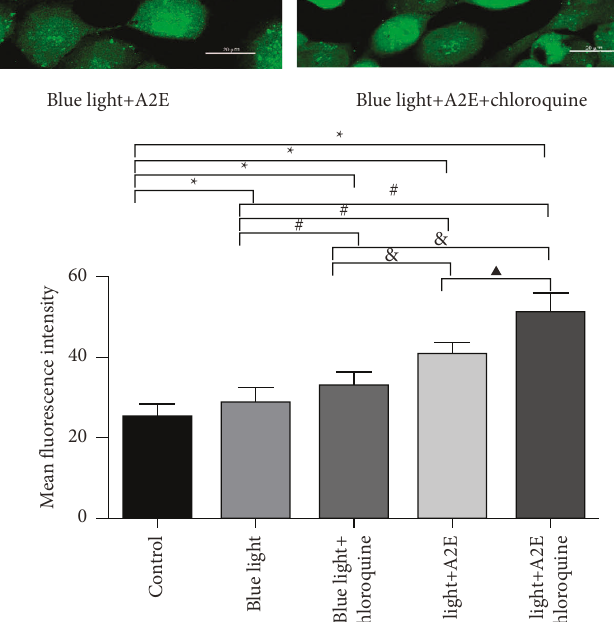
Figure 2: The cytoplasmic Ca 2+ level. To determine the Ca 2+ level in the cytoplasm, the fluorescence intensity of Ca 2+ in RPE cells was assessed by confocal microscopy using the Ca 2+ -sensitive dye Fluo-3/AM. Scale bar � 20 µ m. The graph shows the quantified data. The data are presented as the mean ± SD ( n � 3). An LSD test was conducted following one-way ANOVA. ∗ P < 0 . 05 vs. control cells; # P < 0 . 05 vs. blue light-treated cells; and & P < 0 . 05 vs. blue light +chloroquine-treated cells; ▲ P < 0 . 05 vs. blue light+ A2E-treated